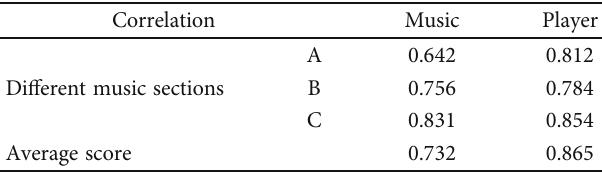
Table 1: Objective music quality assessment.